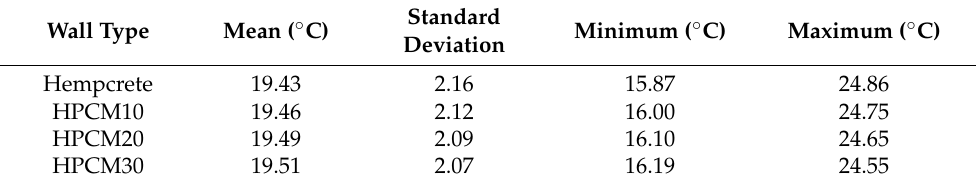
Table 3. Descriptive statistics of assemblies’ interior surface